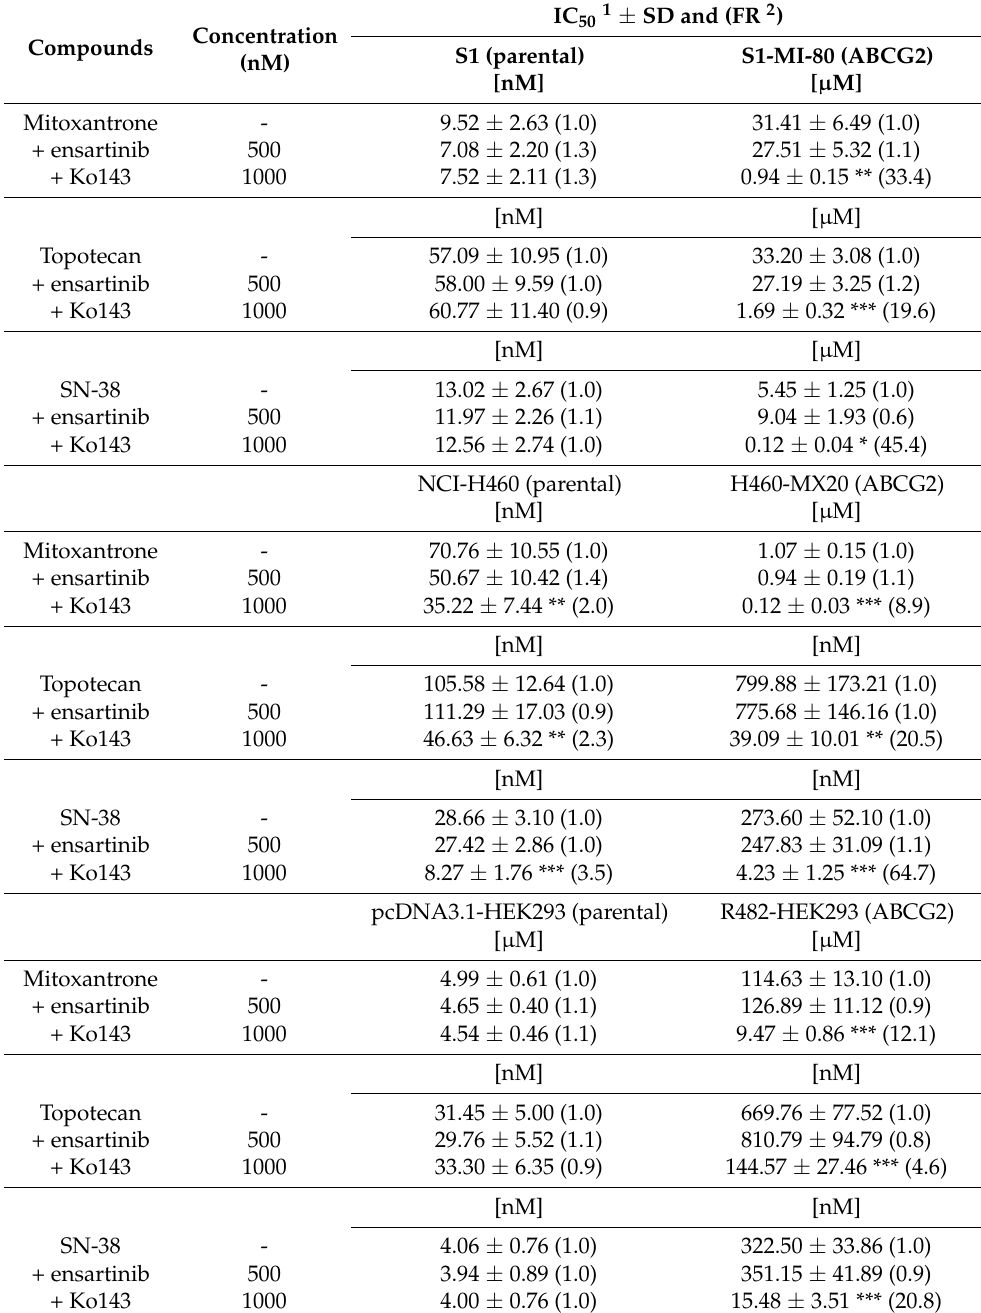
Table 3. Effect of ensartinib on reversing ABCG2-mediated multidrug resistance in drug-resistant human cell